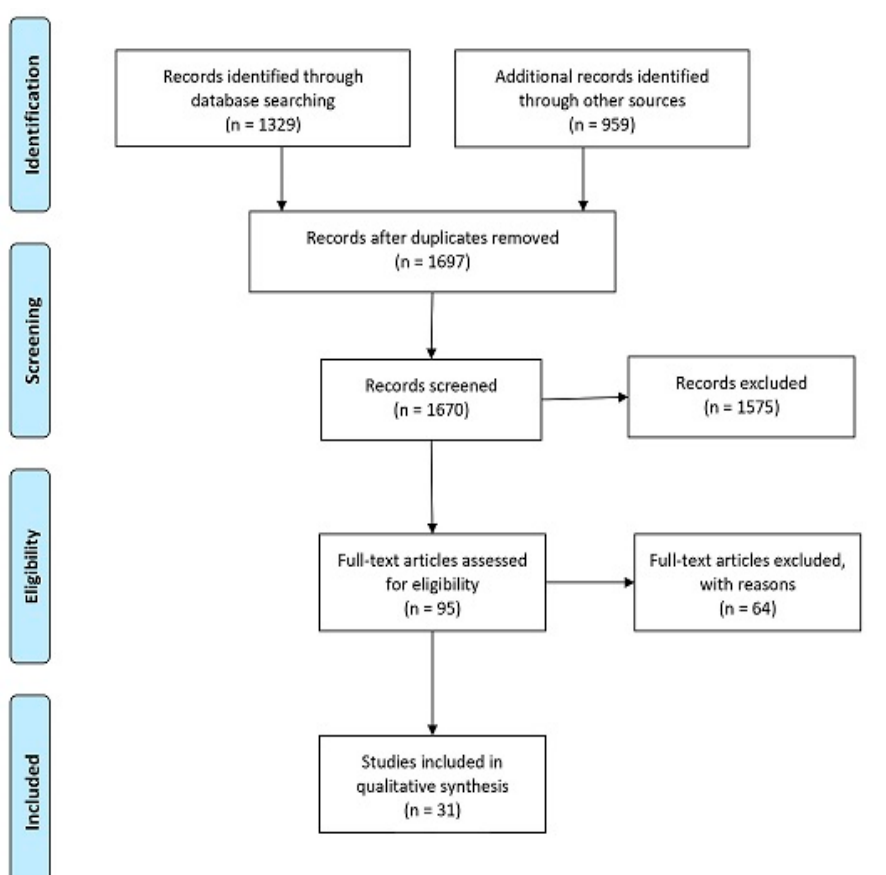
Figure 1. PRISMA flow diagram of article selection.